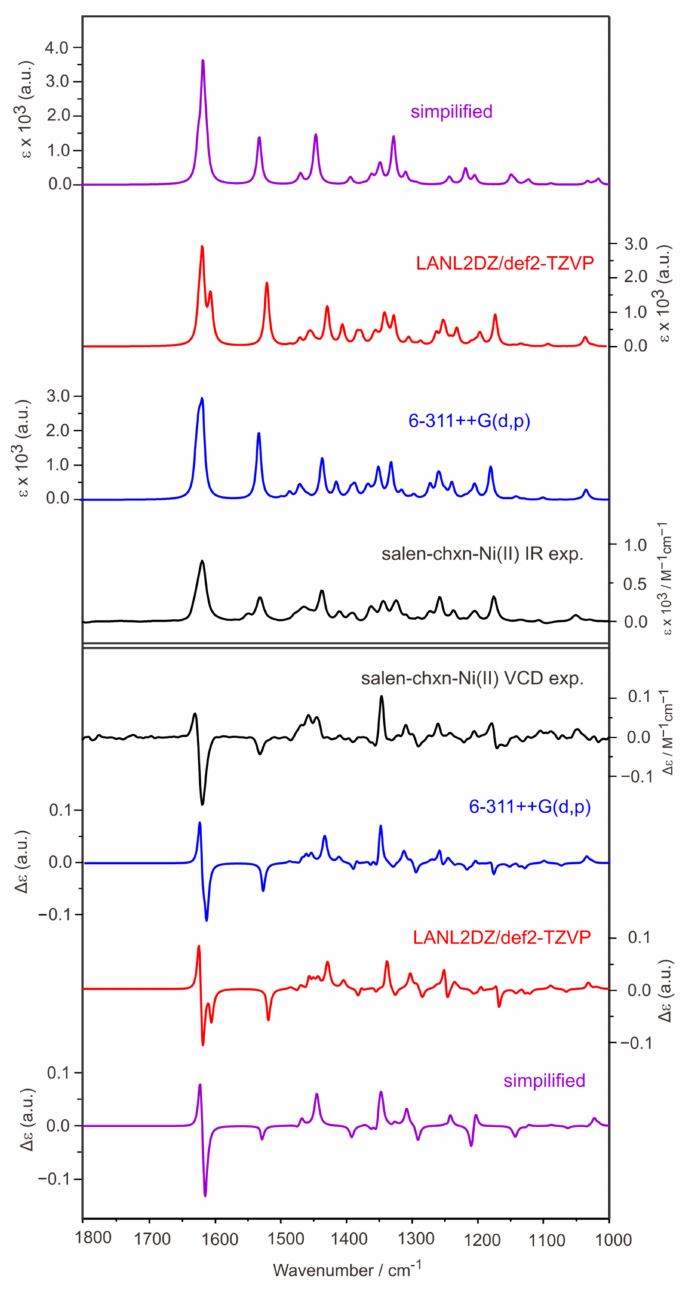
Figure 9. Comparison of the experimental IR ( top ) and VCD ( bottom ) spectra of salen-chxn-Ni(II) with the corresponding calculated spectra in CDCl 3 solution. The levels of theory used are B3LYP- D3BJ/6-311++G(d,p) and B3LYP-D3BJ/def2-TZVP + LANL2DZ(for Ni) with the PCM of chloroform. The simplified calculations were done by replacing tBu with an H